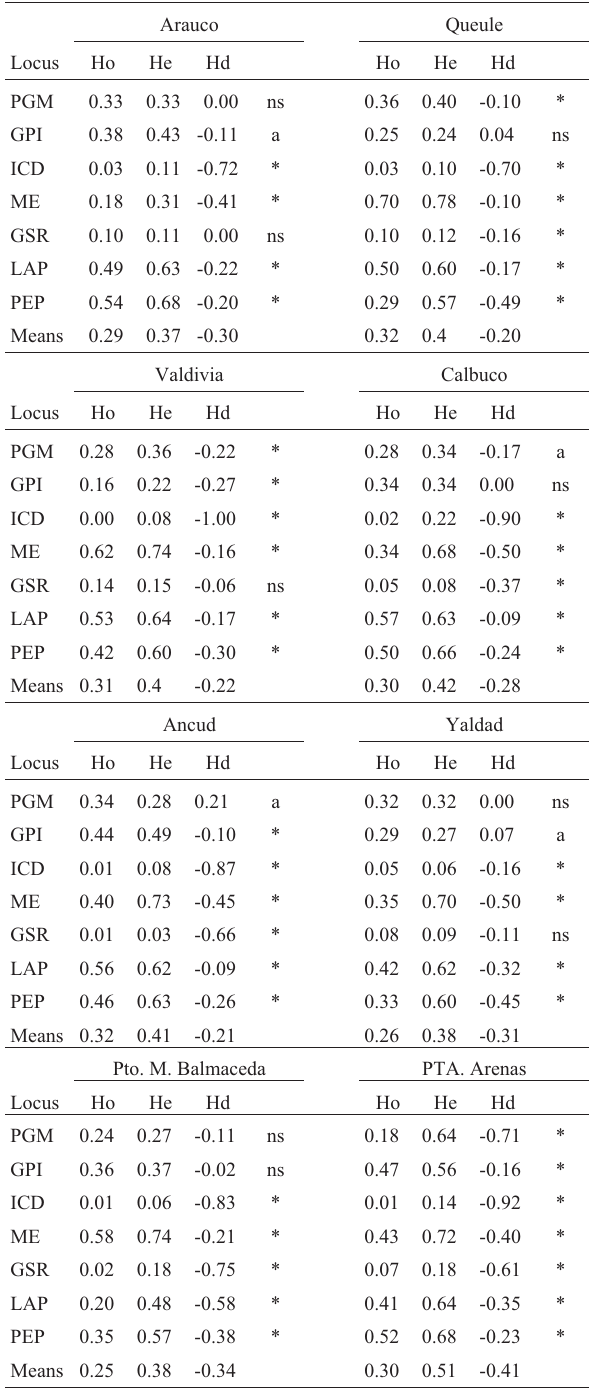
Table 2 - Genetic variability measures for eight populations of Mytilus chilensis